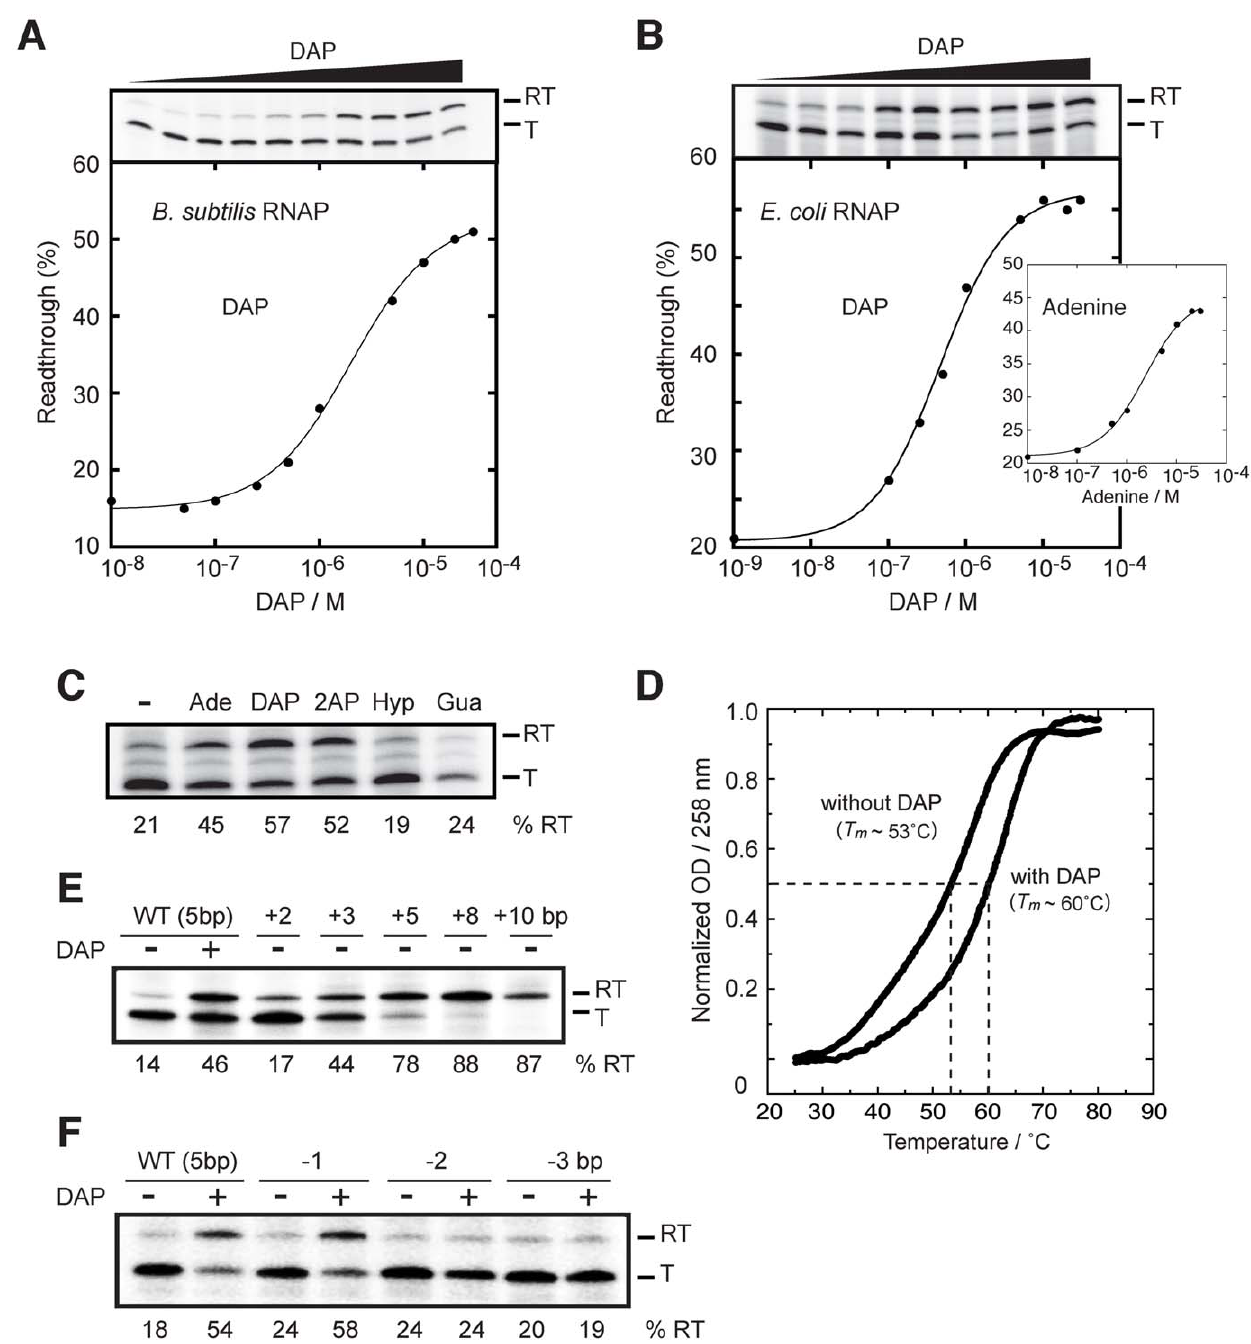
Figure 4. The pbuE riboswitch requires a transcriptional context to bind adenine. (A) Single-round in vitro transcriptions of the pbuE riboswitch using the B. subtilis RNA polymerase (RNAP). Top, transcription reactions performed as a function of 2,6-diaminopurine (DAP). Readthrough (RT) and terminated (T) products are indicated on the right. Bottom, percentage of readthrough products plotted as a function of DAP concentration. The line shows a two-state model from which a T 50 value of 2.1 6 0.2 m M DAP was calculated. (B) Single-round in vitro transcriptions of the pbuE riboswitch using the E. coli RNAP. Top, transcription reactions performed as a function of DAP. Bottom, percentage of readthrough products plotted as a function of DAP concentration. A T 50 value of 0.5 6 0.1 m M was obtained from the fitting. The insert shows transcription reactions performed as a function of adenine concentration. A T 50 value of 2.3 6 0.3 m M was calculated for adenine. (C) Single-round in vitro transcriptions performed in presence of various ligands. Reactions were performed in absence ( 2 ) of ligand and in presence of 10 m M adenine (Ade), 2,6-diaminopurine (DAP), 2-aminopurine (2AP), hypoxanthine (Hyp) and guanine (Gua). Percentages of readthrough (RT) products are indicated below the gel. (D) Thermal denaturation of the pbuE aptamer in absence and in presence of 10 m M DAP. Melting temperatures ( T m ) were evaluated by determining the temperature required to obtain half of themelting transition (normalized OD=0.5) [79,80]. (E) Single-round in vitro transcriptions performed as a function of theP1 stem elongation. The P1 stem was elongated by 2, 3, 5, 8 and 10 bp and resulting constructs were assayed using single-round in vitro transcriptions. The wild-type pbuE riboswitch contains a P1 stem of 5 bp. (F) Single-round in vitro transcriptions performed as a function of P1 stem destabilization. The P1 stem was shortened by 1, 2 and 3 bp and resulting constructs were assayed using single-round in vitro conditions. doi:10.1371/journal.pgen.1001278.g004 PLoS Genetics |